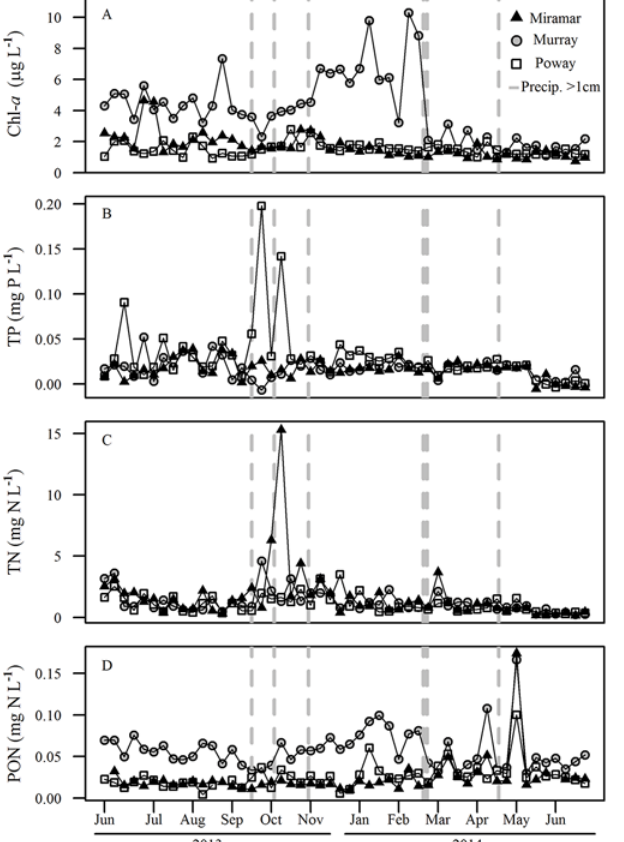
L -1 ), and (D) PON (mg N L -1 ). The vertical dashed lines represent dates that received > 1 cm precipitation. Precipitation during our study period totaled 14.78 cm, and average annual precipitation in San Diego County is 26.26